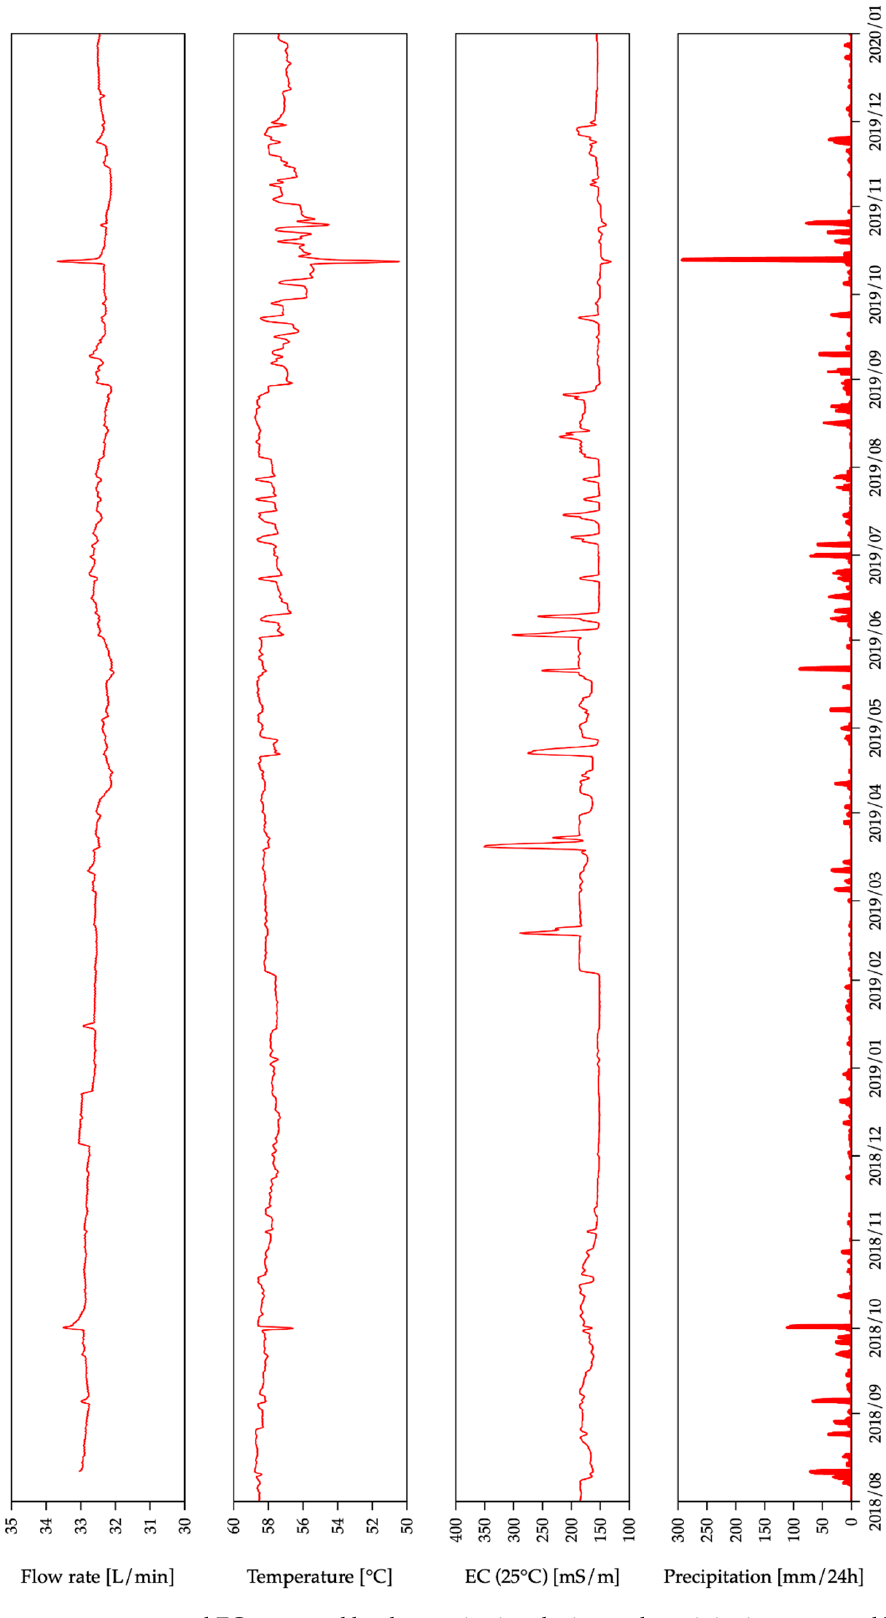
Figure 4. Flow rate, temperature, and EC measured by the monitoring device, and precipitation measured by the AMeDAS Yumoto site. Flow rate, temperature, and EC show the trend for 24 h, and precipitation shows the total for 24 h before measurement. EC is converted from Equation (2) to a value of 25 °C.